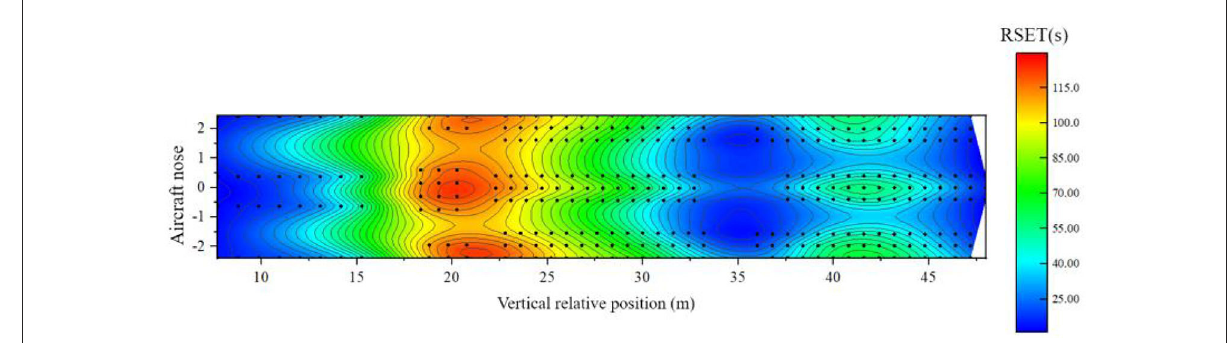
FIGURE16 Distribution of necessary evacuation time when the cabin is horizontal.